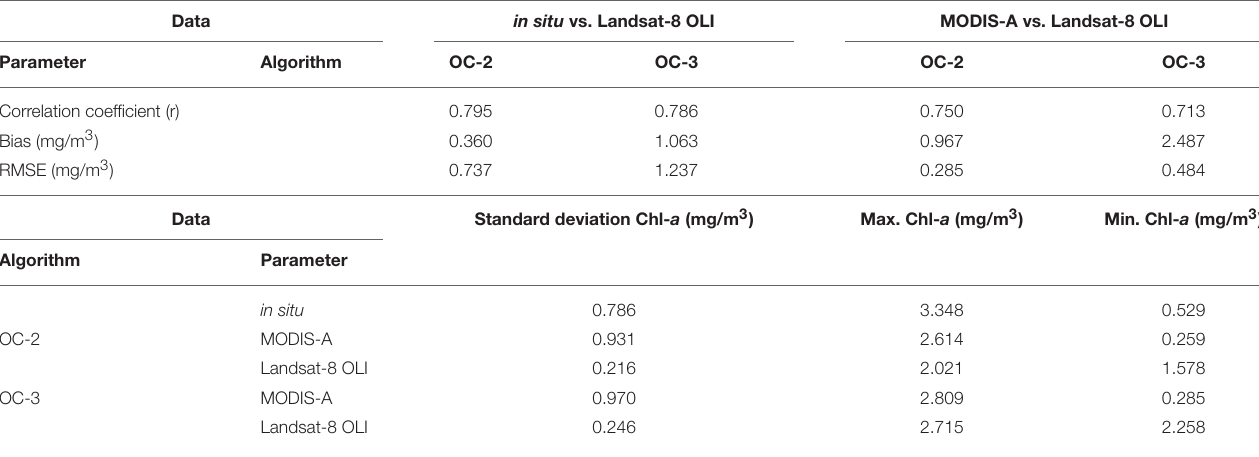
TABLE 3 | Statistical metrics of validation of Chl- a estimated from Landsat-8 OLI by inter-comparison with in situ (COMAPS) and satellite (MODIS-A) data along with details of in situ Chl- a in the region during this